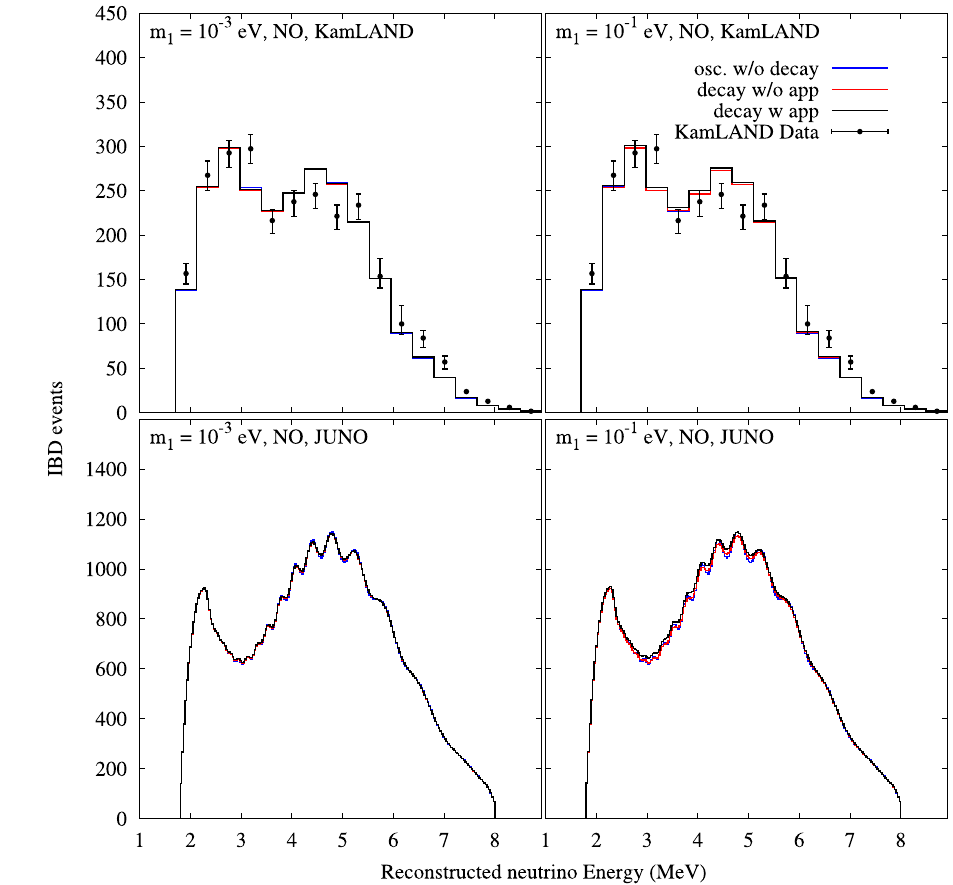
Fig. 3 Events rates vs. reconstructed neutrino energy assuming NO for KamLAND (top panel) and JUNO (bottom panel) with and without the decay effects. The left (right) panels correspond to the choice of m lightest = 10 − 3 eV ( m lightest = 10 − 1 eV). We show the rates for standard oscillations without any decay (labeled “osc. w/o decay” in blue), visible decay without the daughter neutrino contribution (labeled “decay w/o app” in red) and visible decay including the daughter contribution (labeled “decay w app” in black). For the visible decay, we consider g S = g PS = 0 . 2. For these values of the couplings and m lightest , the values of τ 3 / m 3 are 8 . 3 × 10 − 11 s / eV (for m 1 = 10 − 3 eV) and 4 . 6 × 10 − 11 s / eV (for m 1 = 10 − 1 eV). Also shown are the observed KamLAND data indicated by the black solid circles with error bars which are taken from